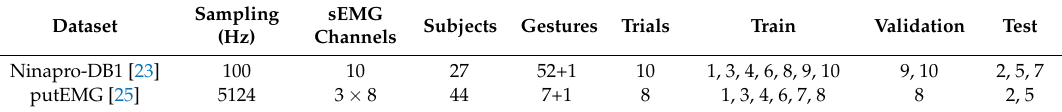
Table A3. Datasets details and partition into train, validation and test sets based on gesture repetitions.